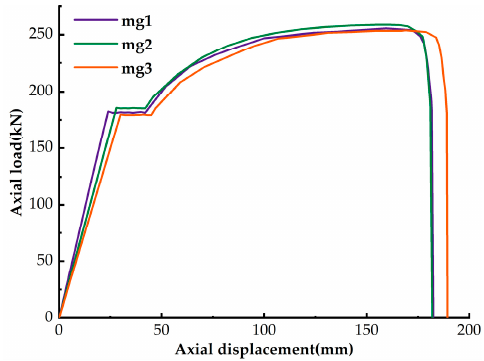
Figure 4. The axial load–displacement curve of each